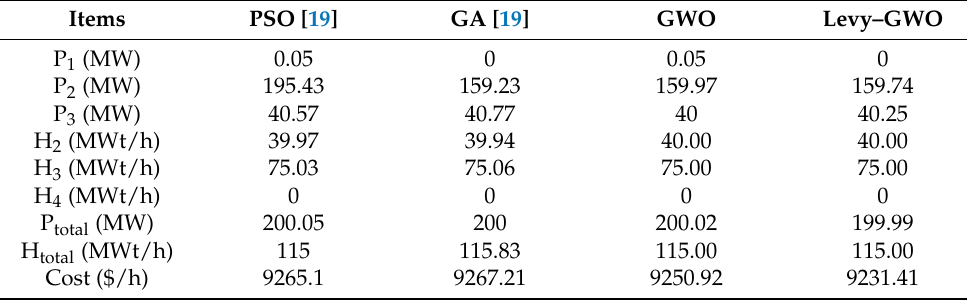
Table 2. Calculation results of different optimization algorithms for test system I.